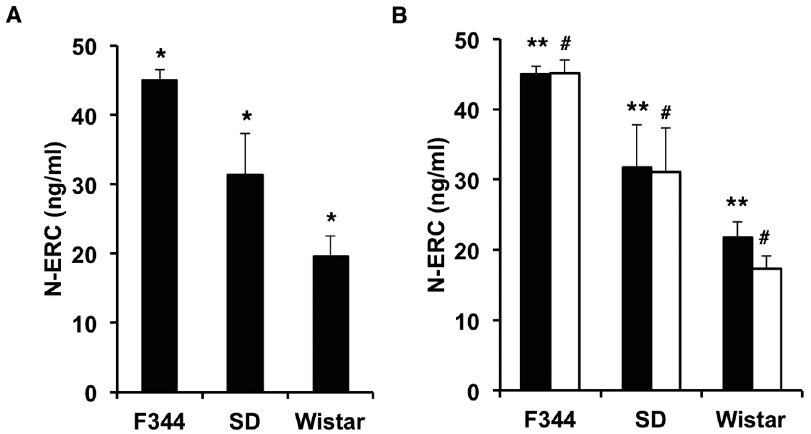
Figure 2. Comparison of serum levels of N-ERC/mesothelin in F344/DuCrlCrlj (F344), Slc:SD (SD) and Slc:Wistar/ST (Wistar) rat strains. (A) Strain differences in the serum levels of N-ERC/mesothelin. (B) Serum levels of N-ERC/mesothelin in males (closed bar) and females (open bar) of the different rat strains. *, P , 0.0001; **, P , 0.005; # , P , 0.0001 compared with each other.